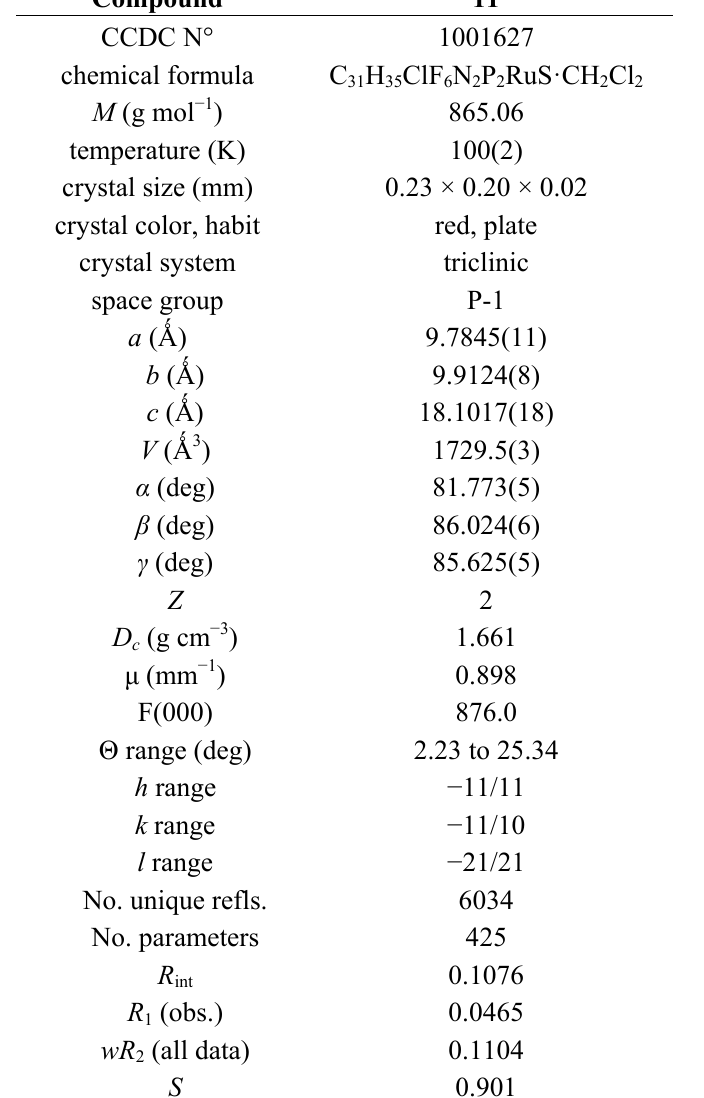
Table 1. X-ray diffraction parameters for the measurement of single crystals of 11